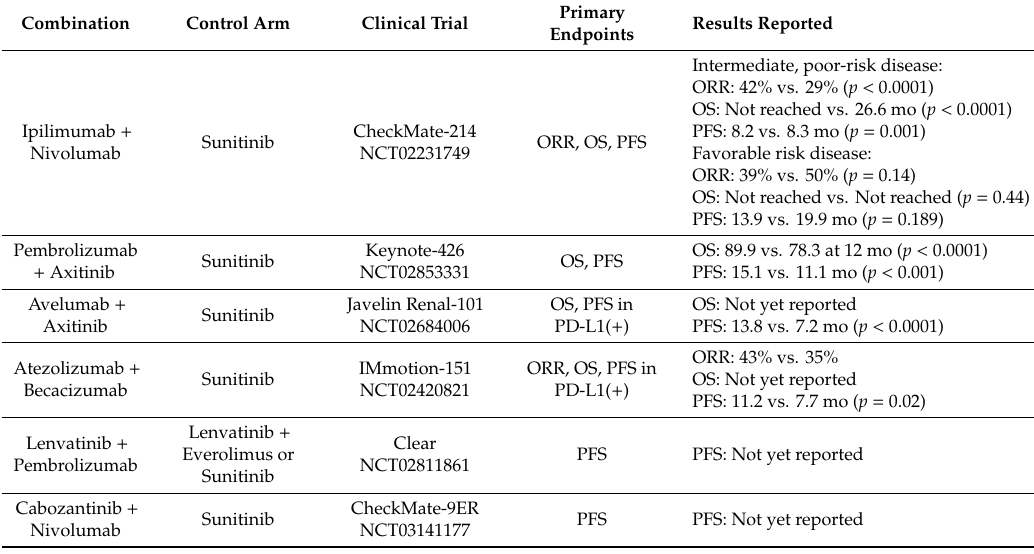
Table 2. E ffi cacy results of Phase III clinical trials comparing immune checkpoint inhibitors in combination strategies with single-agent